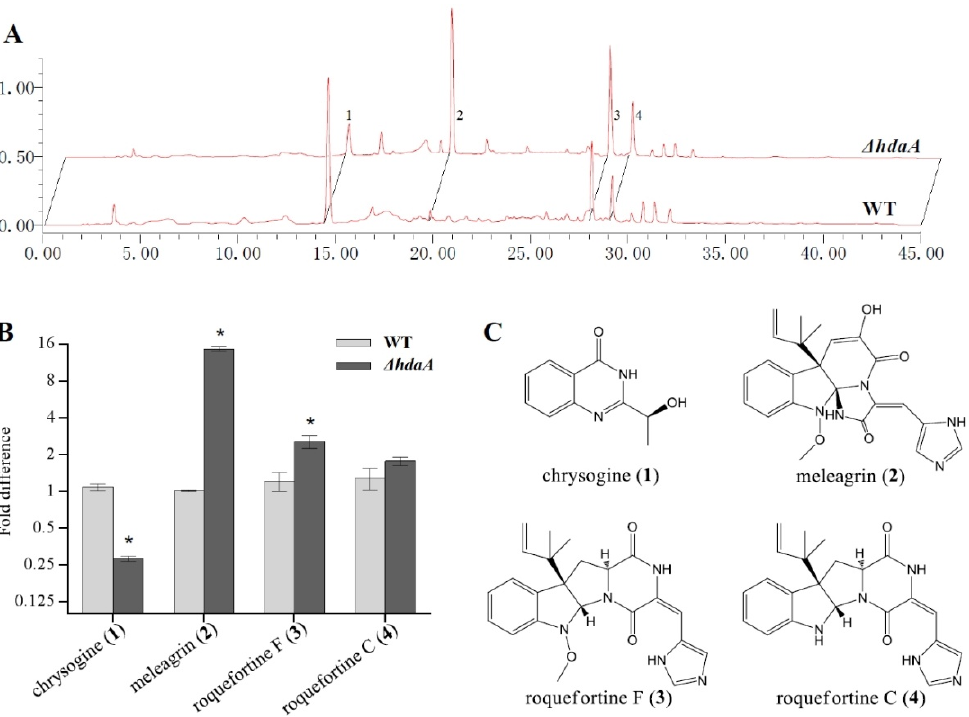
Figure 3. Secondary metabolite profiles of ∆ hdaA and WT strains. ( A ) HPLC analysis of secondary metabolite profiles. ( B ) Relative amounts of four main products 1–4 in ∆ hdaA compared with the WT. Mean values with asterisks are significant. ( C ) The chemical structure of the four main products detected in this study: 1, chrysogine; 2, meleagrin; 3, roquefortine C; 4, roquefortine F. The analysis for each strain was performed in triplicate. Mean values with asterisk are significant at p < 0.01.